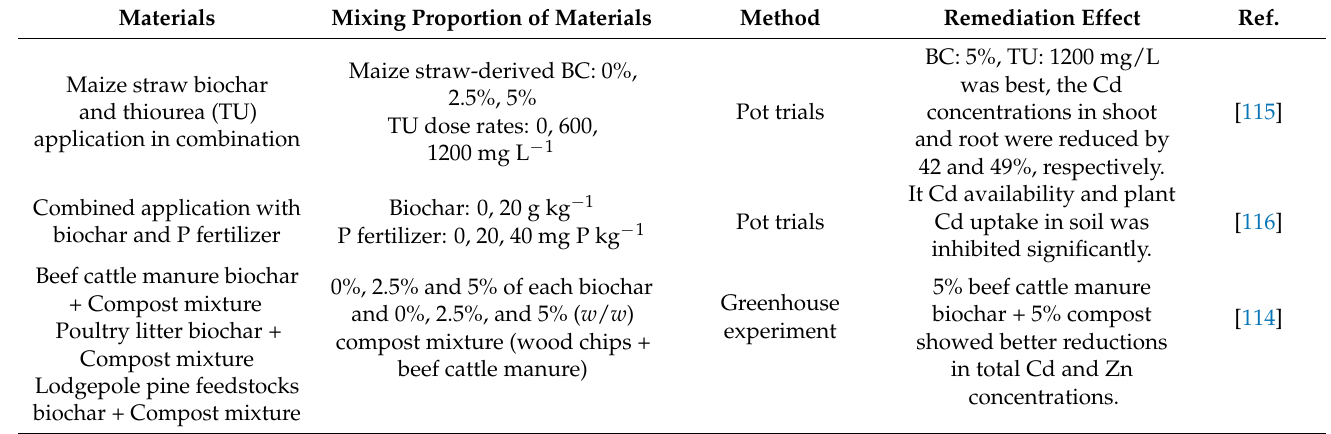
Table 6. Remediation of Cd pollution in soil by co-applying biochar and other remediation